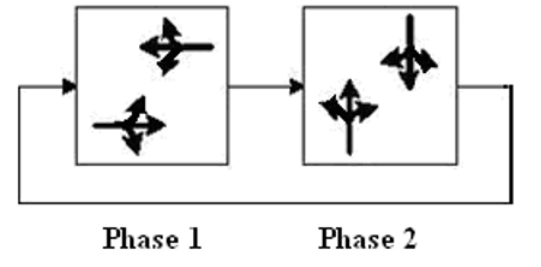
Figure 3. Phase diagram for two-phase